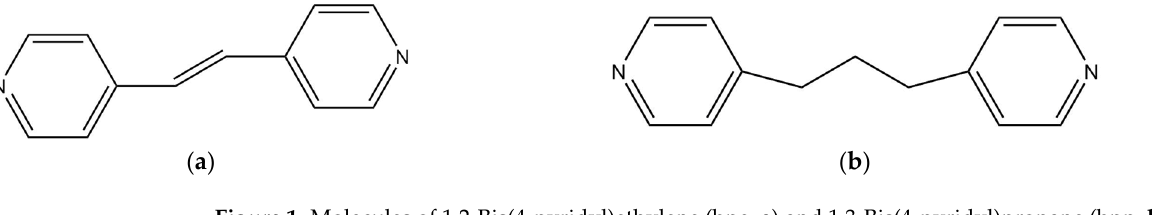
Figure 1. Molecules of 1,2-Bis(4-pyridyl)ethylene (bpe, a ) and 1,3-Bis(4-pyridyl)propane (bpp, b